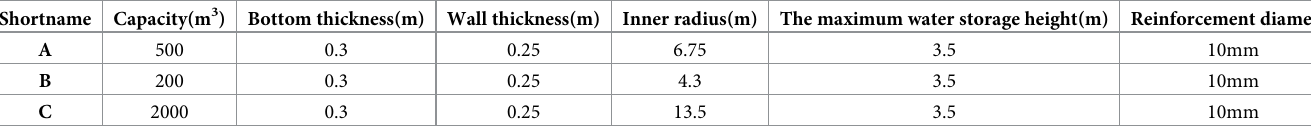
Table 3. Structure characteristics of the circular